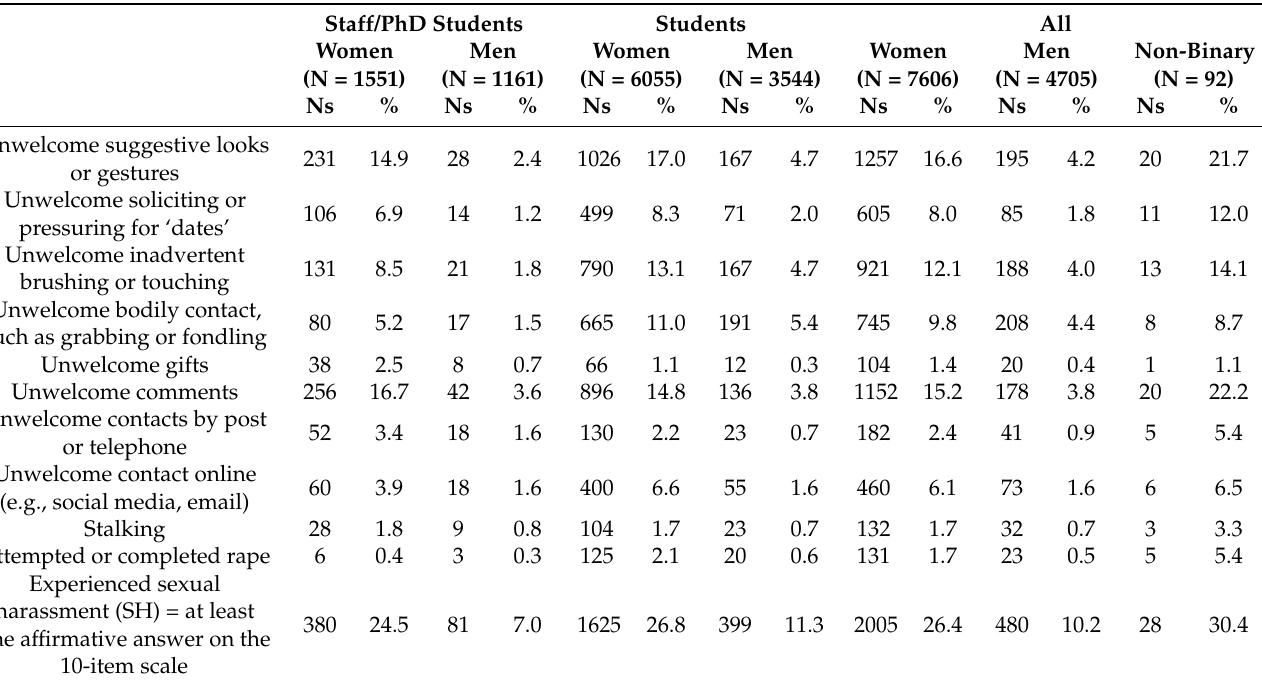
Table 2. Participants, presented as numbers and percentages, in the Tellus survey, who affirmed having experienced different kinds of sexual harassment, at least once since they arrived at Lund